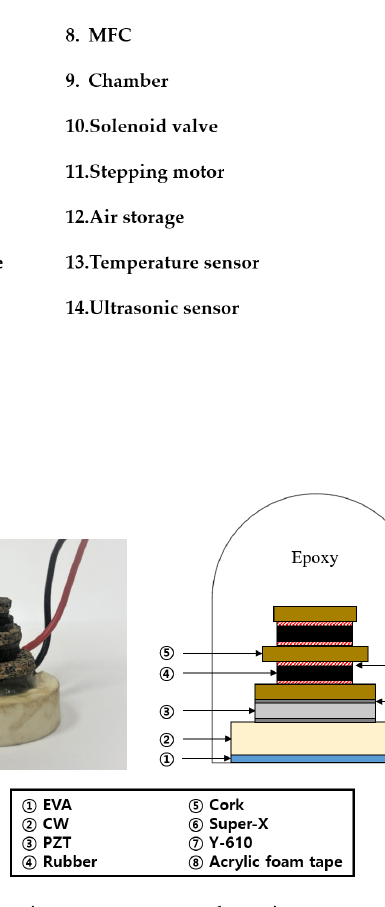
Figure 2. Ultrasonic sensor structure